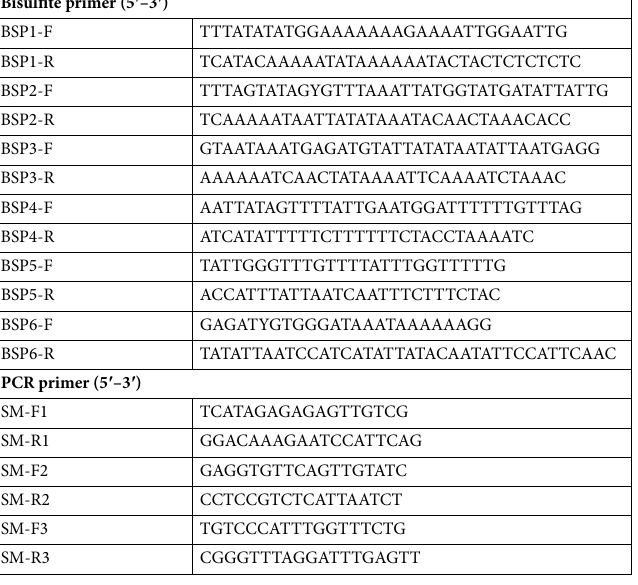
Table 2. Primers used in this